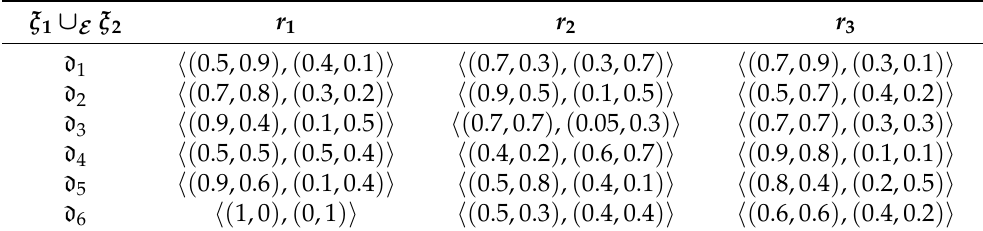
Table 11. Table for the extended union ξ 1 ∪ E ξ 2 .